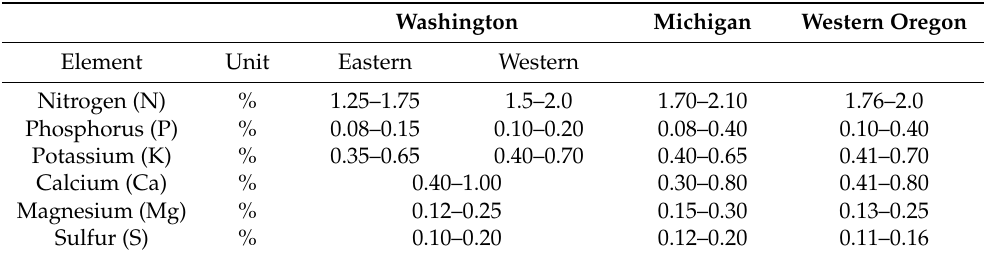
Table 3. Recommended ranges of northern highbush blueberry tissue macronutrient levels in eastern and western Washington when leaf samples are collected between 1–31 August. (DOY 212–243). Recommended ranges are listed from previous research in western Oregon [1] and Michigan